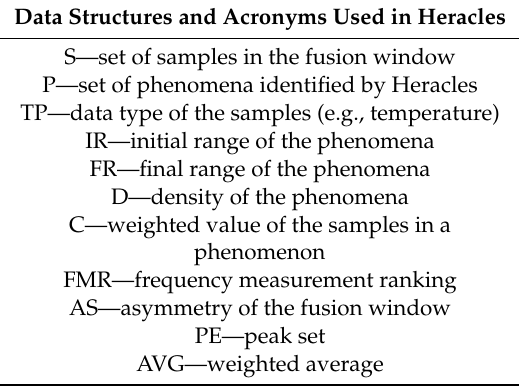
Table 1. Heracles data structures and